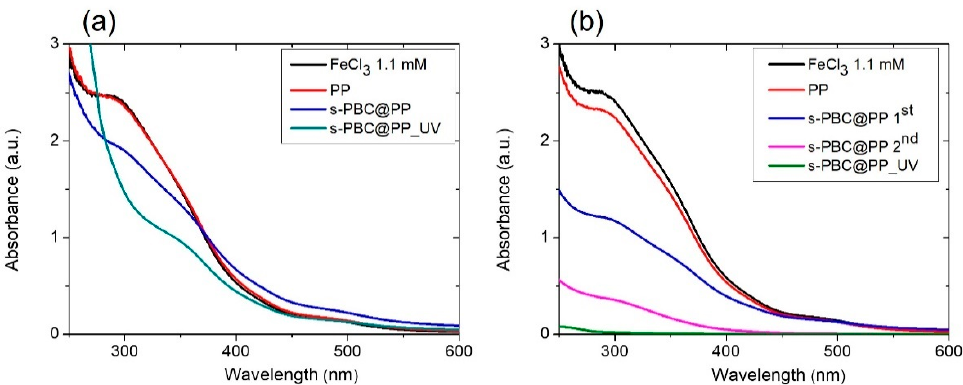
Figure 4. UV-Visible absorbance spectra of FeCl 3 solutions after ( a ) adsorption on the different filters or ( b ) filtration through them. The reference spectrum of the initial FeCl 3 solution is reported in both